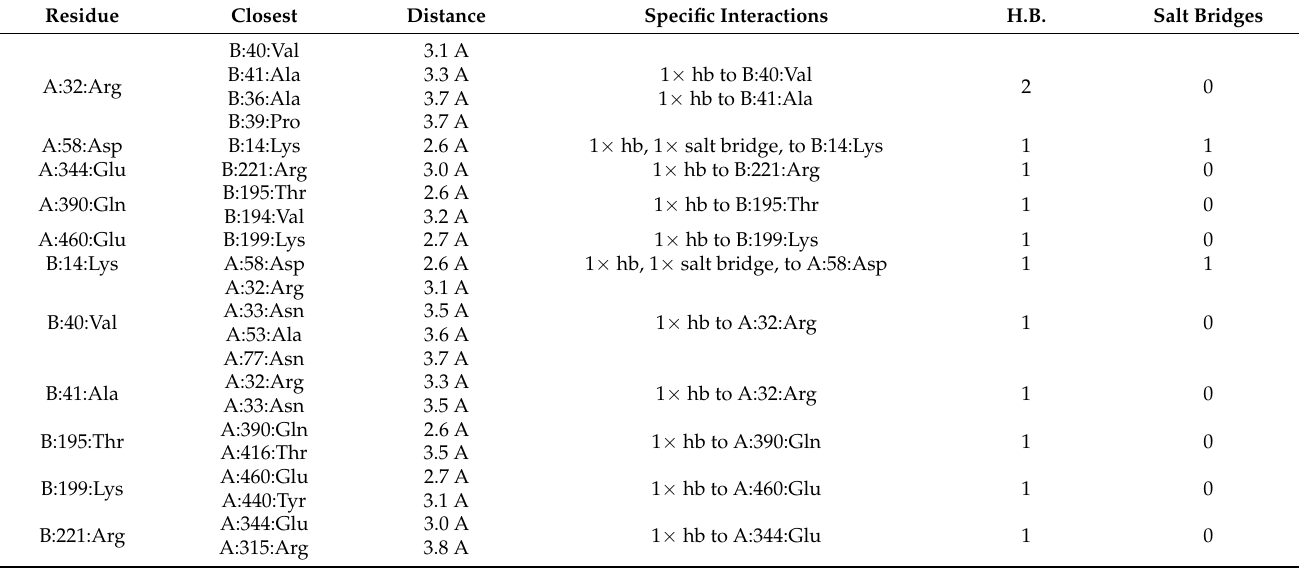
hb = hydrogen bond, A = protein chain, B = ligand–protein